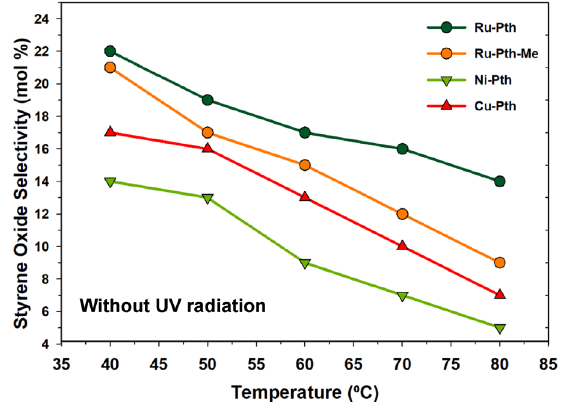
Figure 6. Effect of the temperature on the styrene oxide selectivity over Ru-Pth, Ru-Pth-Me, Ni-Pth and Cu-Pth complexes without UV radiation. Reaction conditions: catalyst: styrene (1:100); styrene to H 2 O 2 ratio of 1; acetonitrile: 50 mL; reaction time: 3 h.